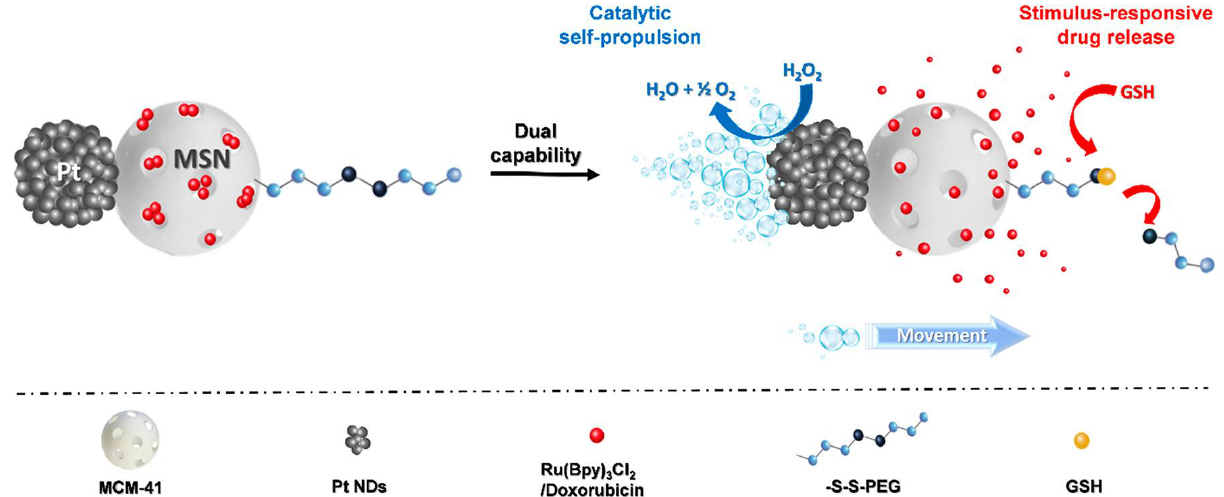
Figure 9. Schematic representation of Pt-MSNs nanomotors with a catalytic self-propulsion and a glutathione-mediated [222]. Copyright © 2022 American Chemical Society.